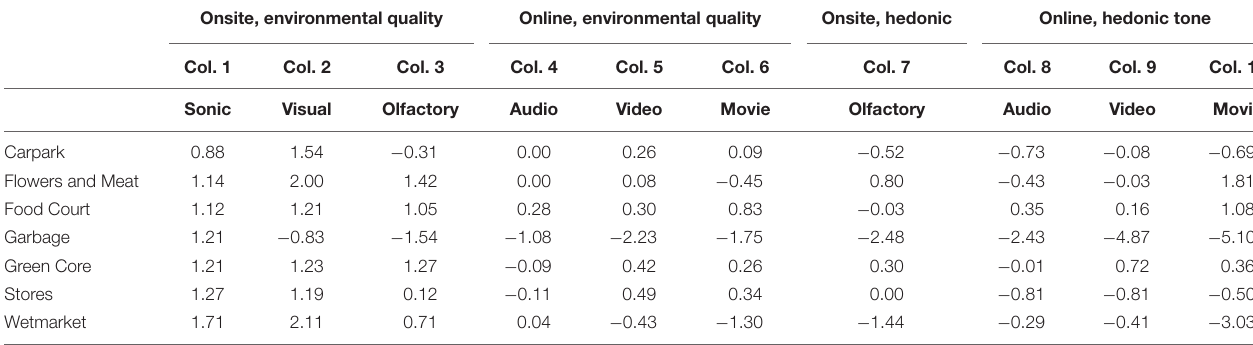
TABLE 1 | Mean ratings of environmental quality and hedonic tone in the two